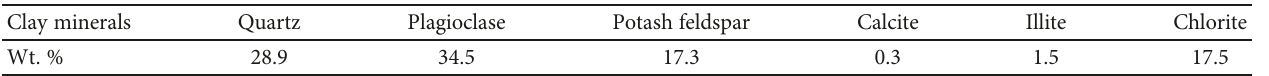
Figure 17: Di ff erent modes of irreducible water microoccurrence in the throat system: (a) curved piece-necking pattern (complete blockage, ine ff ective percolation channel); (b) slug- fi lling (partially blockage, ine ff ective percolation channel); (c) water- fi lm pattern (partial blockage, e ff ective percolation channel). Note: the yellow area represents a given pore or throat surface and the blue area represents irreducible water. Table 2: XRD results of the core sample.